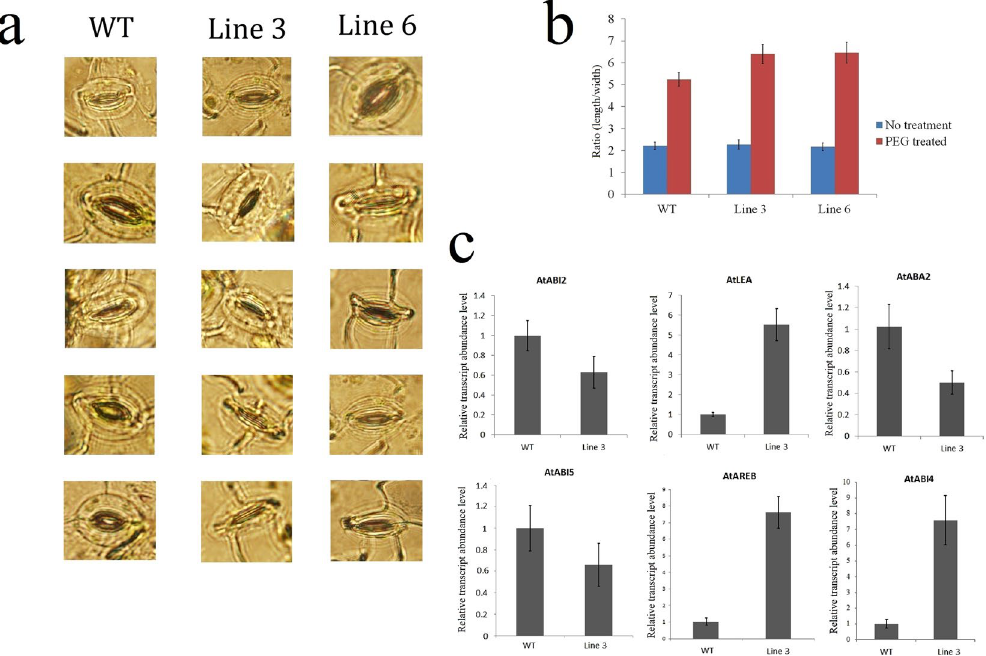
Figure 8. (a) Comparison of the stomatal aperture between transgenic and WT plants in response to drought stress. ( b ) Ratios of stomatal closure. The ratio of the length to the width was used as a measurement of stomatal closure. ( c ) Expression of ABA-signalling genes in WT and 35S-OsWRKY72 transgenic Arabidopsis under drought stress for 3 h. The expression of each gene in WT was arbitrarily set at 1.0. qRT-PCR analysis was based on three biological replicates of each sample and three technical replicates of each biological